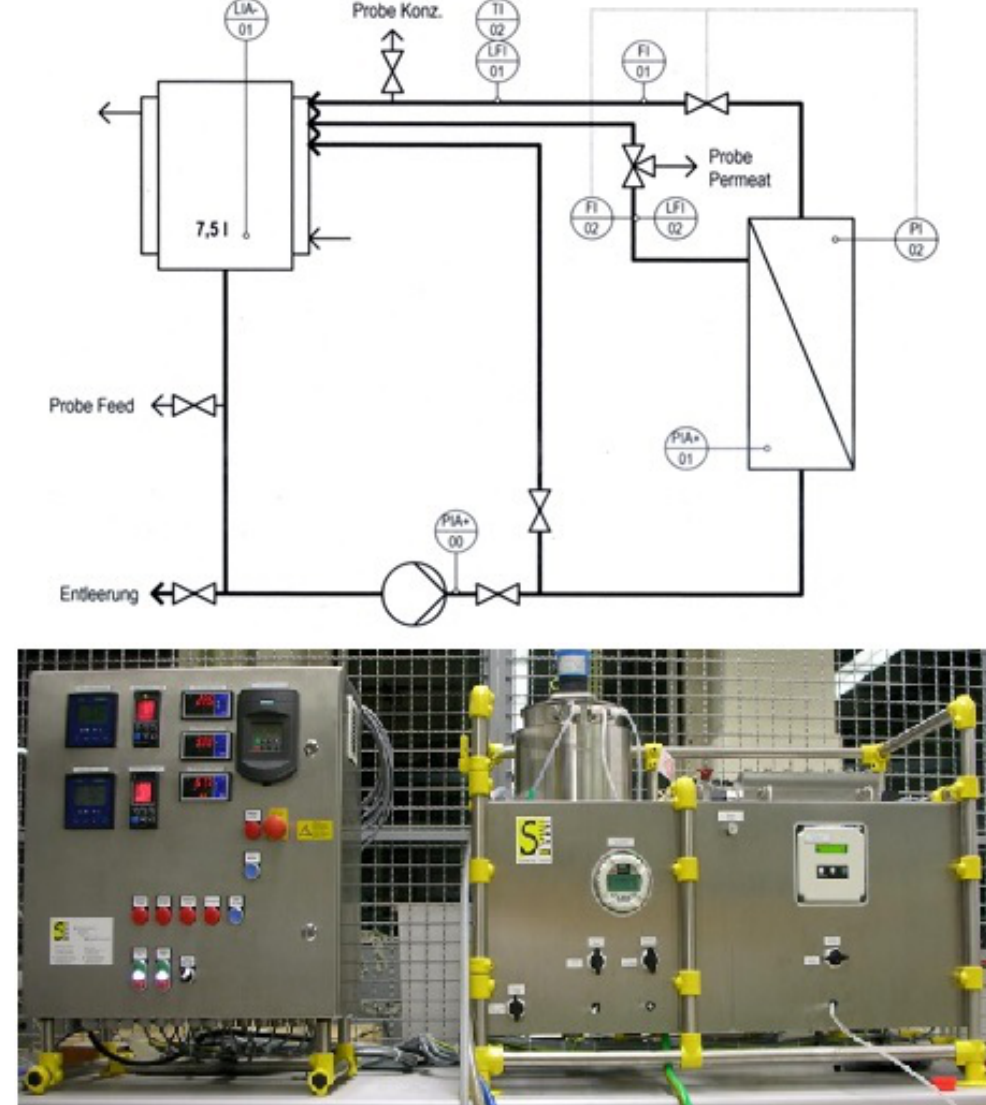
Figure 2. Flat sheet membrane test system